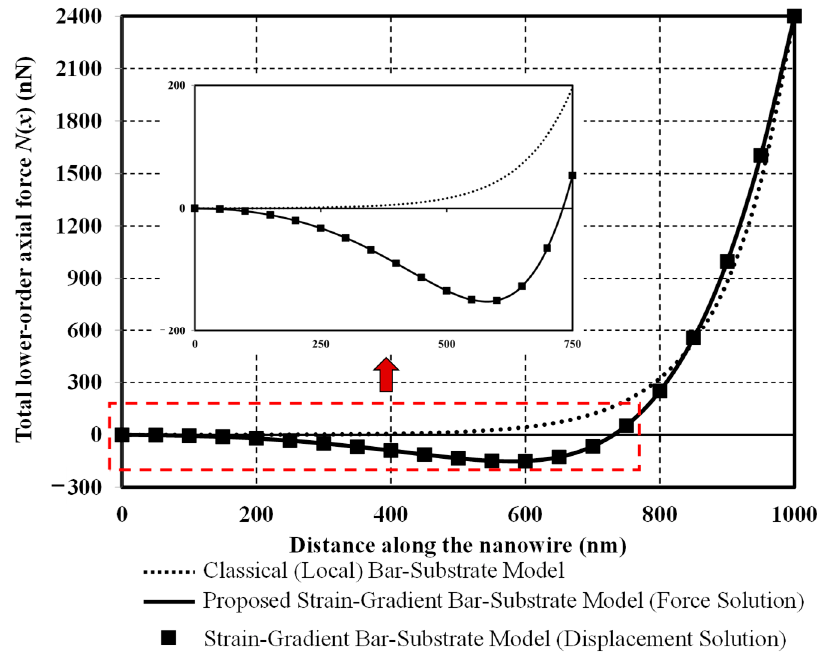
Figure 8. Total lower-order axial force versus distance along the nanowire.